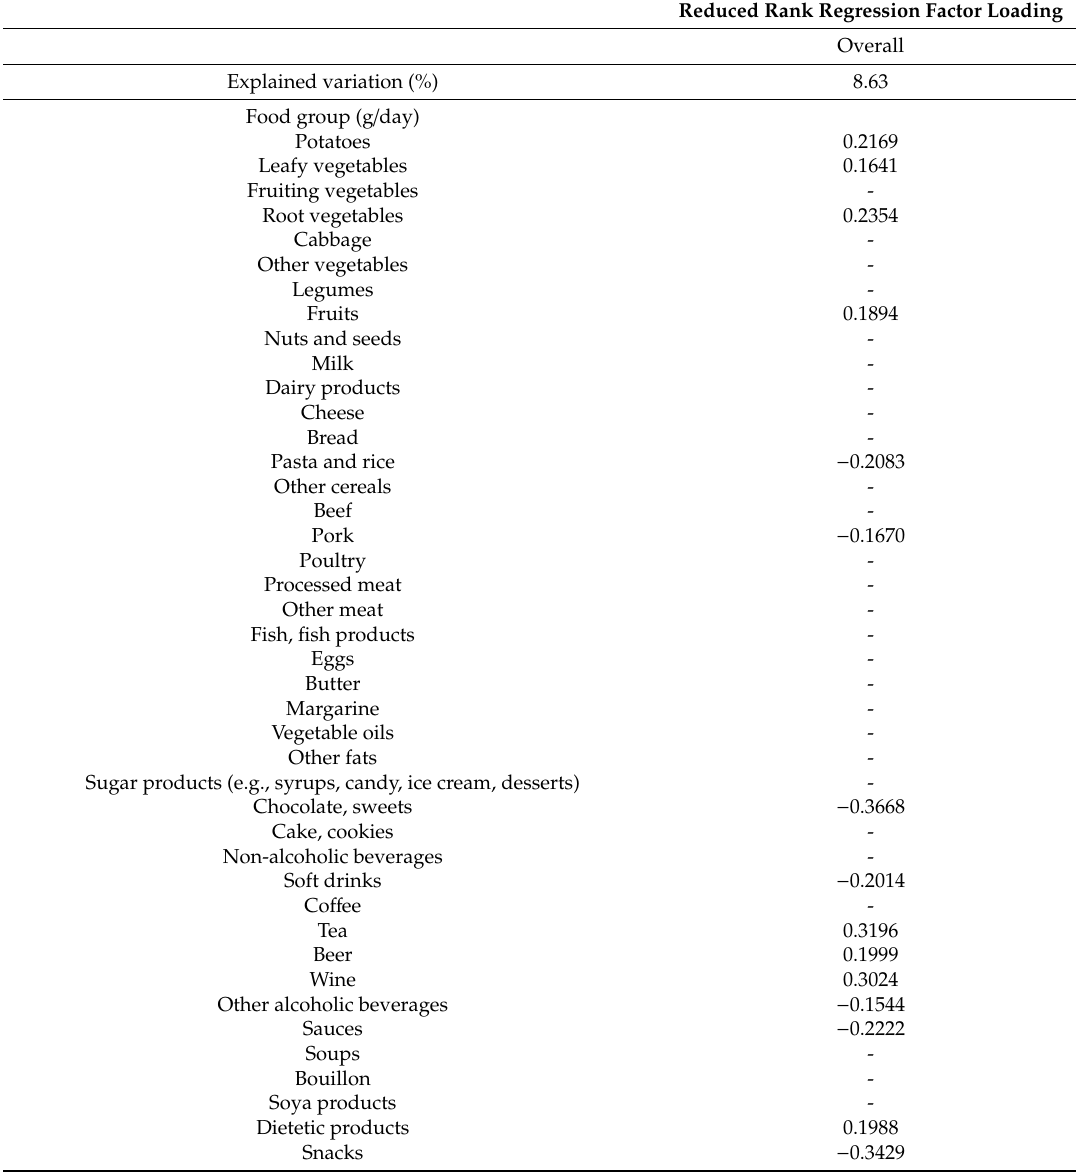
Table 5. Factor loadings in 42 food groups and explained variation in log-transformed lithium plasma concentration by using reduced rank regression ( n =